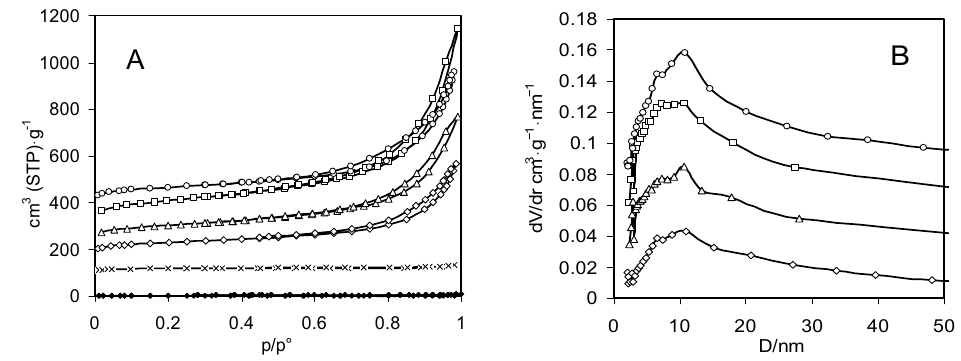
Figure 3. N 2 adsorption-desorption isotherms ( A ) and pore size distributions ( B ) of zeolite X (crosses) and aerogels (void symbols) and xerogels (filled symbols) of chitosan (circles) and composites A (squares), B (triangles), and C (lozenges). Aerogel curves are shifted by 100 cm 2 (STP)·g − 1 in Figure 3A and by 0.02 cm 3 ·g − 1 ·nm − 1 in ( B ).